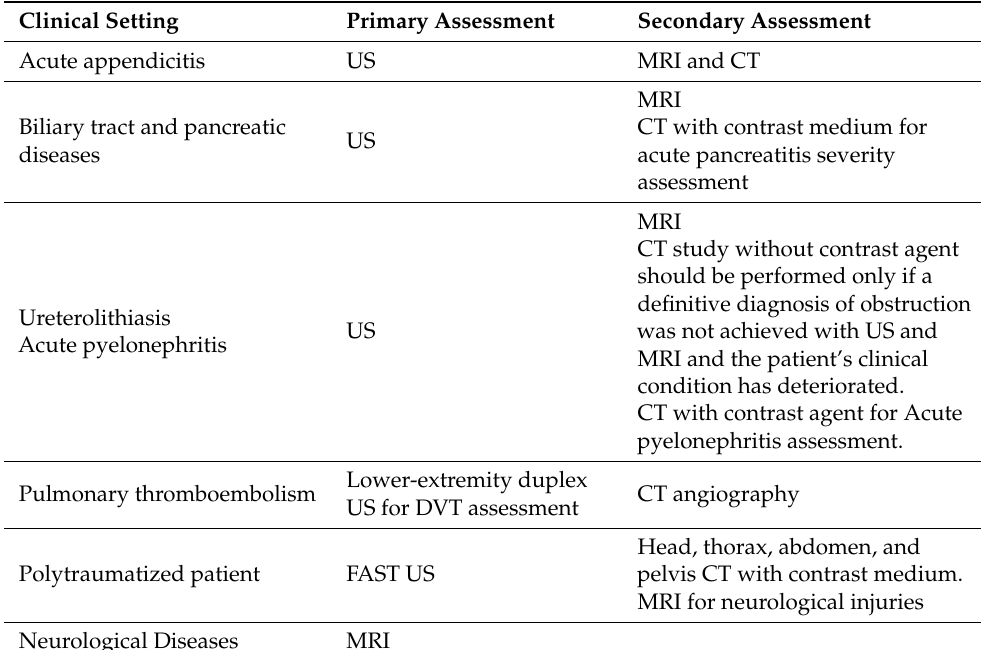
Table 1. Clinical setting and imaging tools